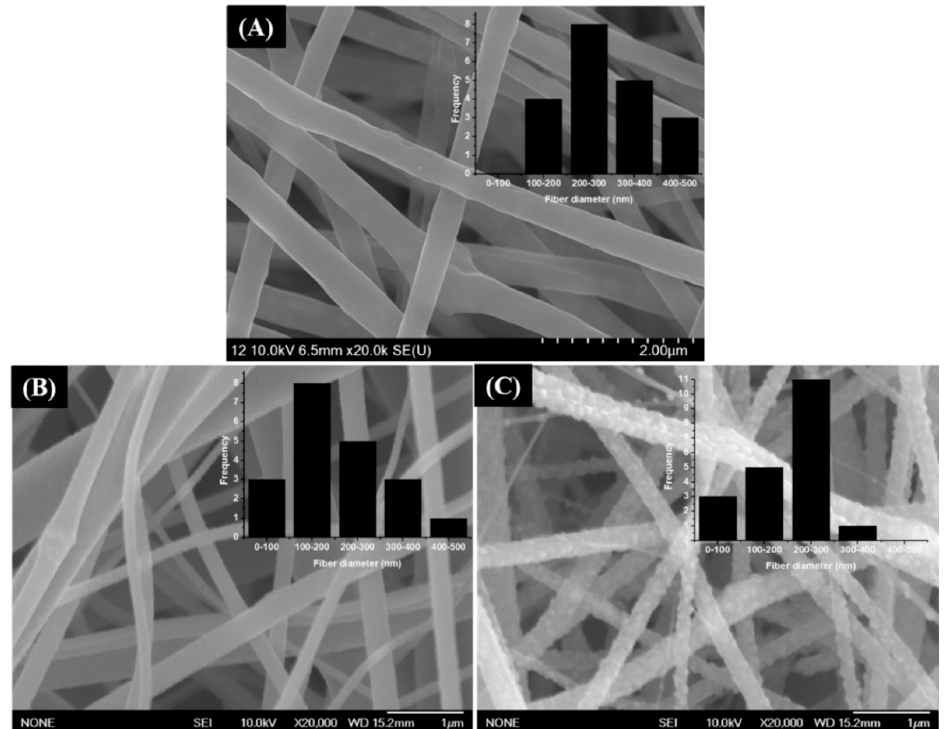
Figure 4. Field-emission scanning electron microscopy (FE-SEM) images of an as-spun nanofiber membrane ( A ), pristine TiO 2 NFs ( B ), and TiO 2 -carbon NFs ( C ). The insets show their corresponding diameter distributions.